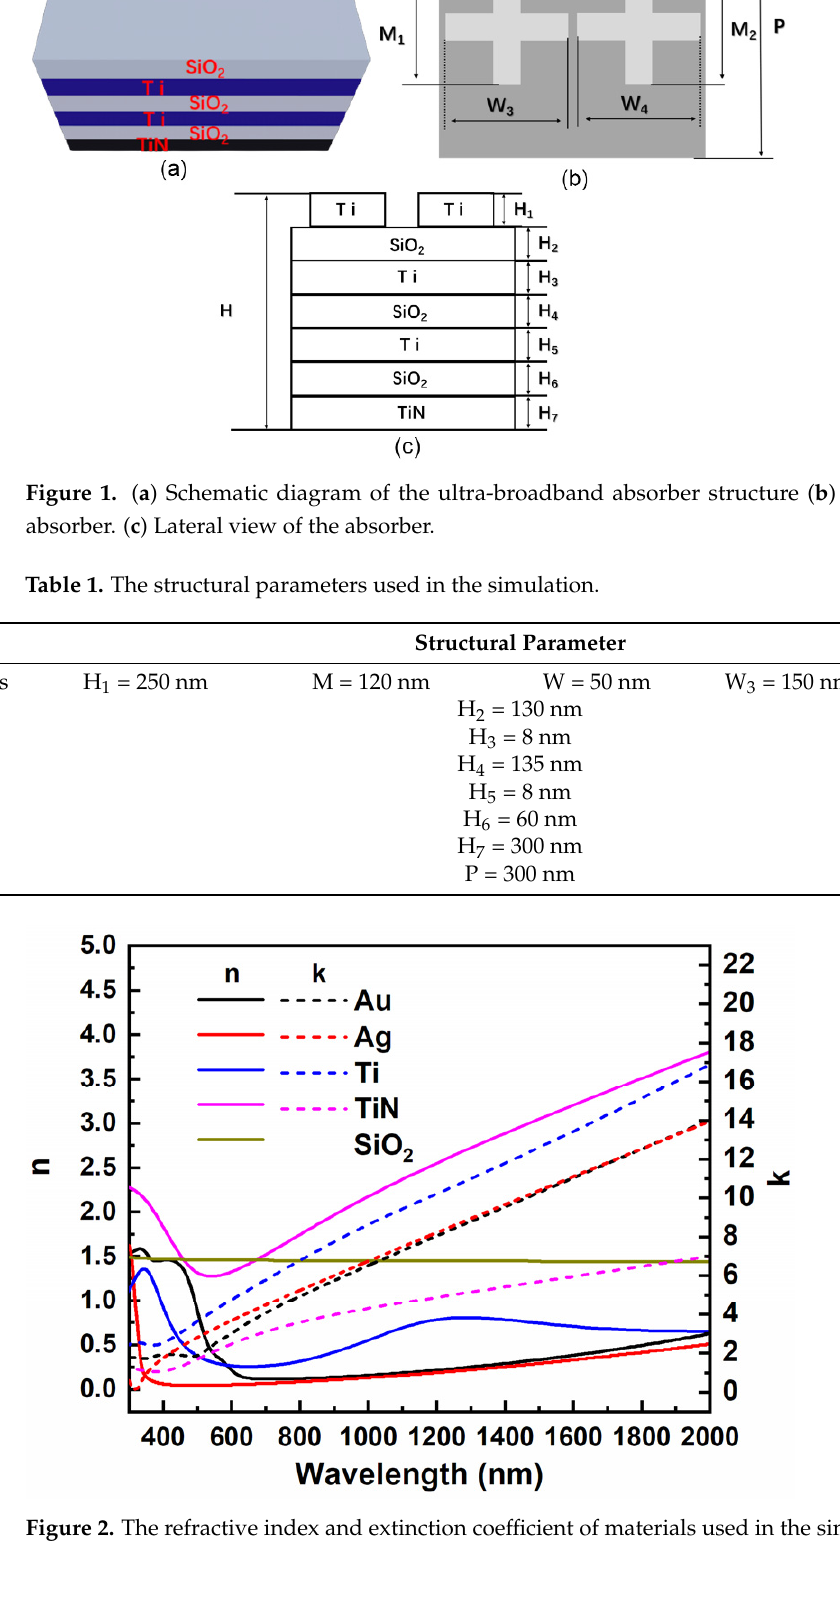
Figure 2. The refractive index and extinction coefficient of materials used in the simulation.